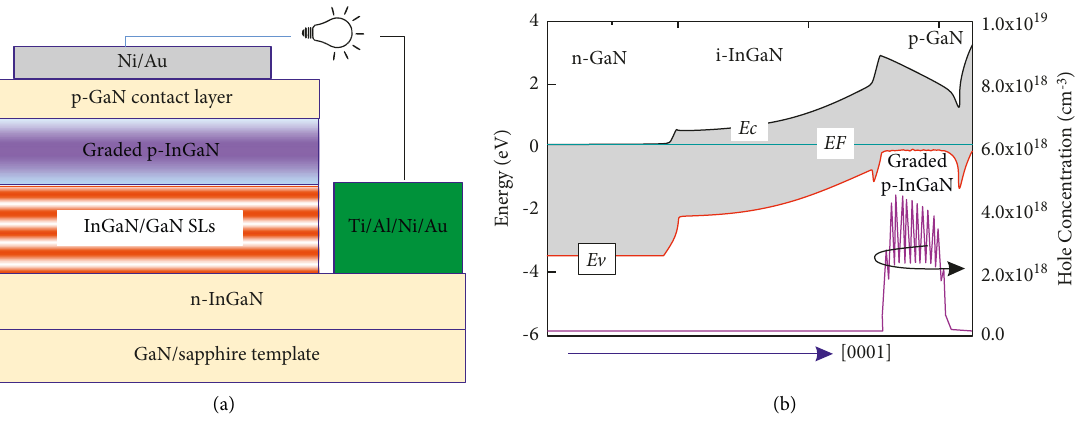
Figure 1: Wavelength of GaN devices with multiple layers.